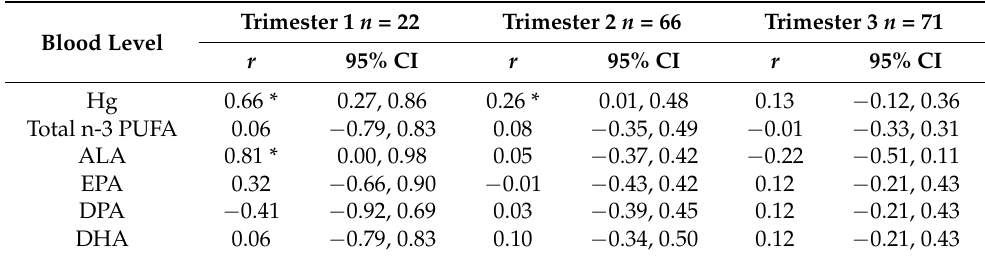
Table 4. Spearman’s correlation coefficients comparing reported seafood consumption and blood levels stratified by trimester.